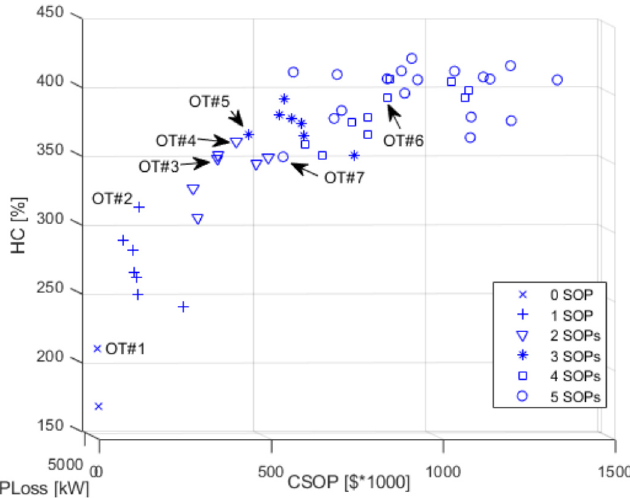
Figure 14. 2-D Pareto front (CSOP × HC).